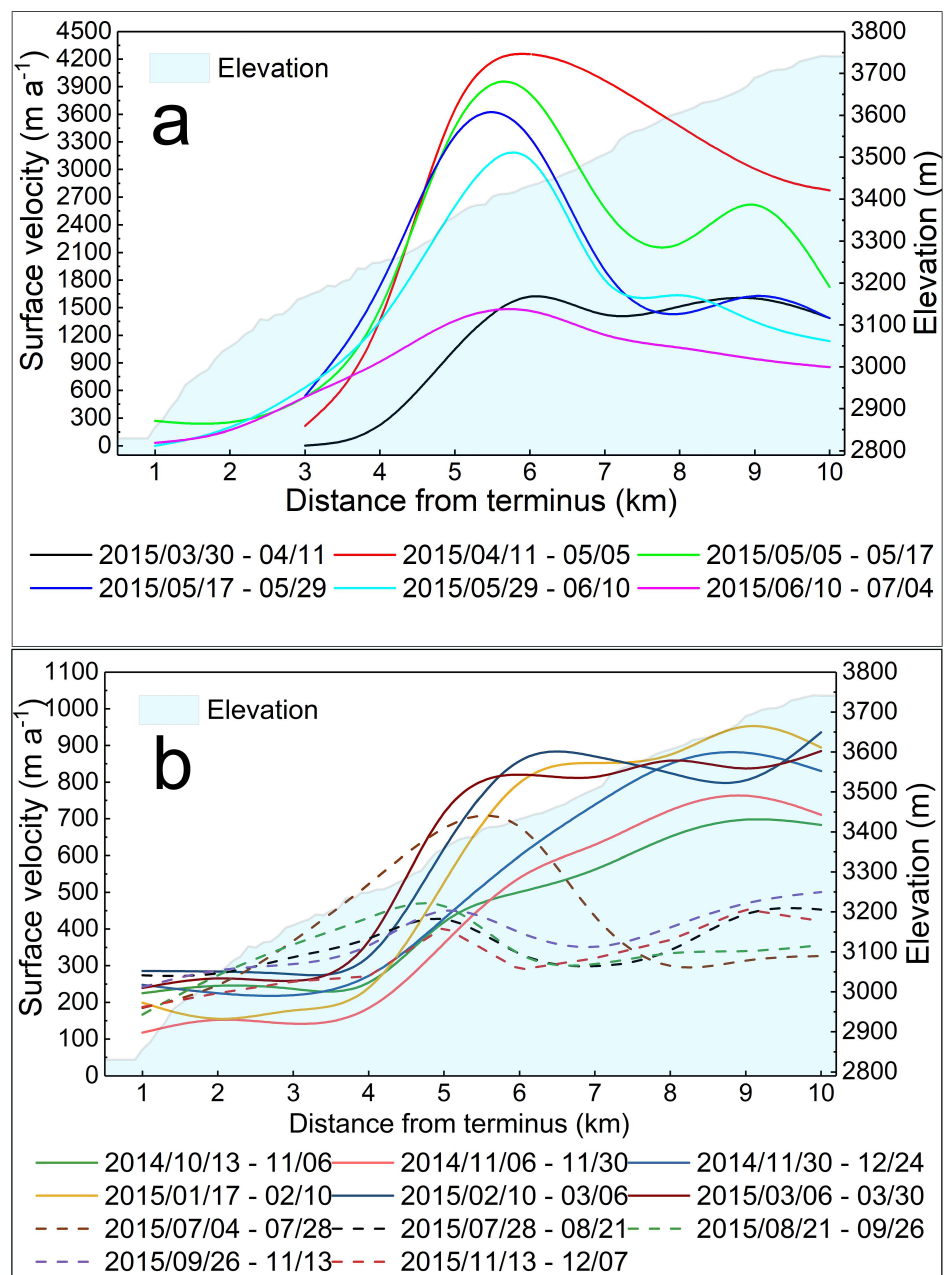
Figure 5. The most excessive surface velocity from 13 October 2014 to 7 December 2015. Panel ( a ) shows the velocities from 30 March 2015 to 4 July 2015. The solid line in panel ( b ) represents the velocity before 30 March and the dotted line shows the velocity after 30